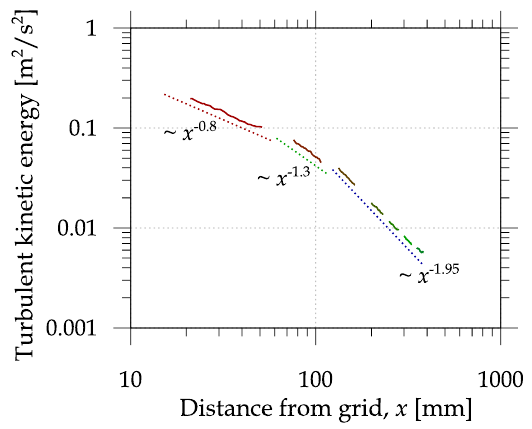
Fig. 5. Top : Stream-wise velocity u measured by using PIV (solid lines) and LDA (stars). The PIV data is processed by 2 ways: it is averaged over the span-wise direction ( y ) or there is selected only a single profile in the wake of the grid rod. Bottom : Standard deviation of the stream-wise velocity. This is plotted instead of TKE, which needs all three velocity component, while our LDA system measures only one component. Again, the PIV data are selected to the averaged ones and those from the wake only, which gives highest di ff erence at locations close to the